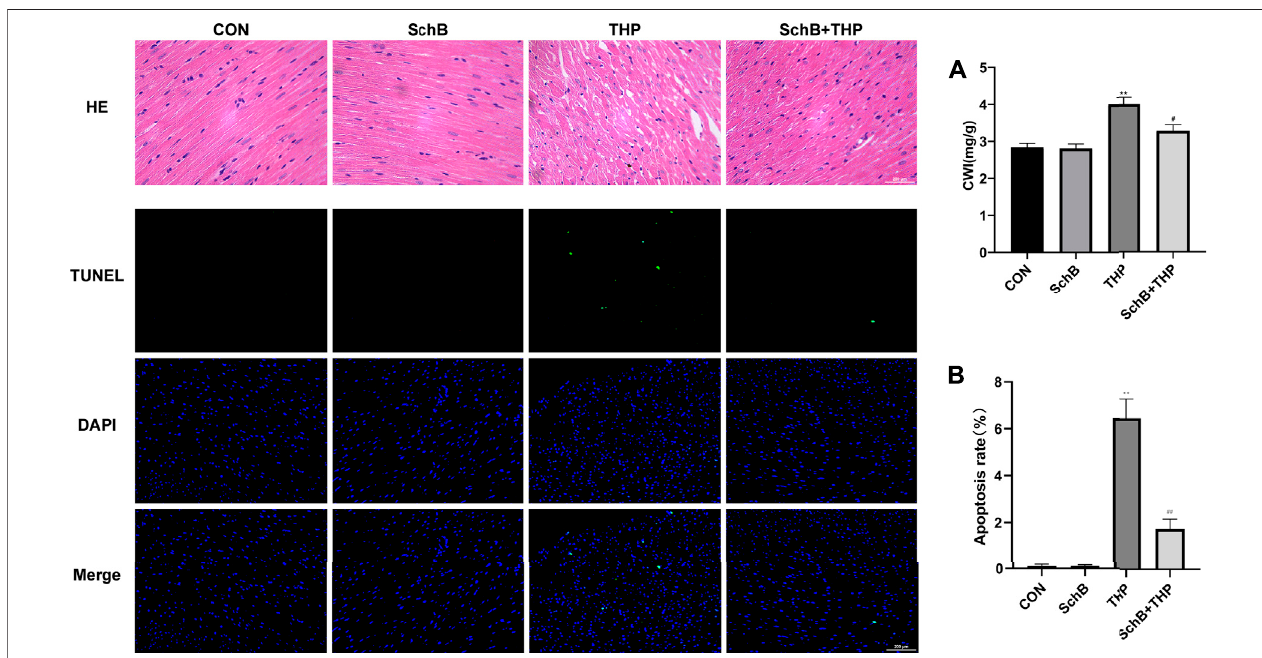
FIGURE 3 | SchB attenuated THP-induced cardiac histopathological changes, apoptosis, and increased CWI. The myocardial tissue structure of the CON and SchB group was normal. In the THP group, the arrangement of cardiomyocytes was disordered, the intercellular space was signi fi cantly increased, and the cardiomyocytes were focal vacuolization or steatosis. The vacuolation and steatosis of myocardial cells in rats treated with SchB were signi fi cantly improved. TUNEL stainingshowedthattherewasnoapoptosisinthecontrolgroupandSchBgroup.IntheTHPgroup,therewaspartialapoptosis.InthegroupofSchB+THP,afew or a single cell apoptosis was occasionally observed. The CWI of rats in the THP group was signi fi cantly higher than that in the normal group, and the CWI of rats in the SchB +THP groupwassigni fi cantlylowerthan thatintheTHP group. Allvaluesarethemean ± SD. *p < 0.05 vs. CON , ** p < 0.01 vs.CON , # p < 0.05 vs.THP , and ## p < 0.01 vs. THP